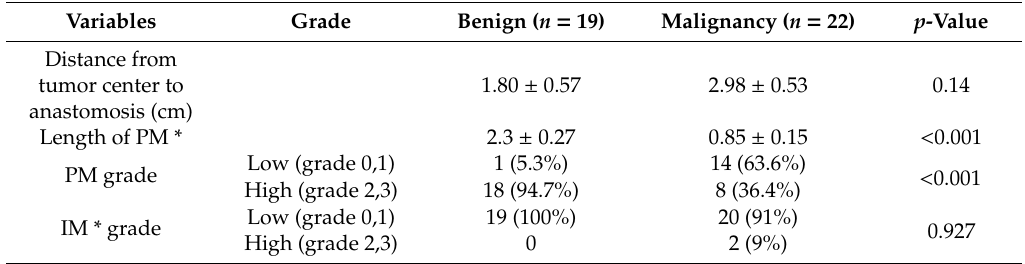
Table 3. Tumor location and the mucosal characters of anastomosis area.